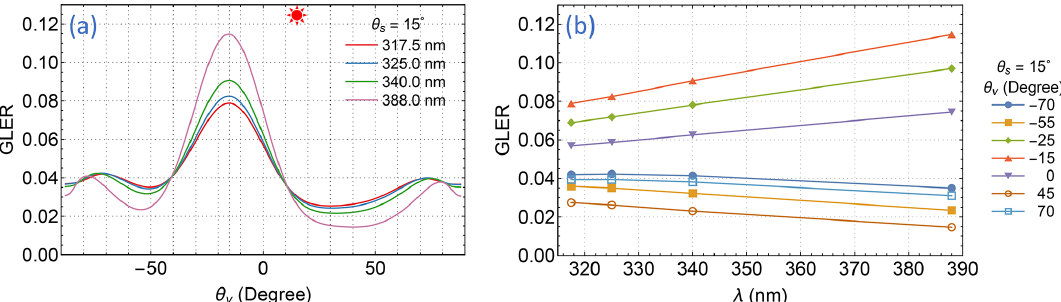
Figure 4. Apparent reflectances of an ocean surface described by a Cox–Munk BRDF (Cox and Munk, 1954a, b) for a wind speed of 6ms − 1 , viewed along the plane of incidence with the Sun at a zenith angle of θ s = 15 ◦ . (a) GLER at four EPIC UV bands vs. viewing zenith angle θ v . Here positive θ v denotes φ = 0 ◦ and negative θ v for φ = 180 ◦ . (b) GLER at several viewing zenith angles vs. wavelength λ